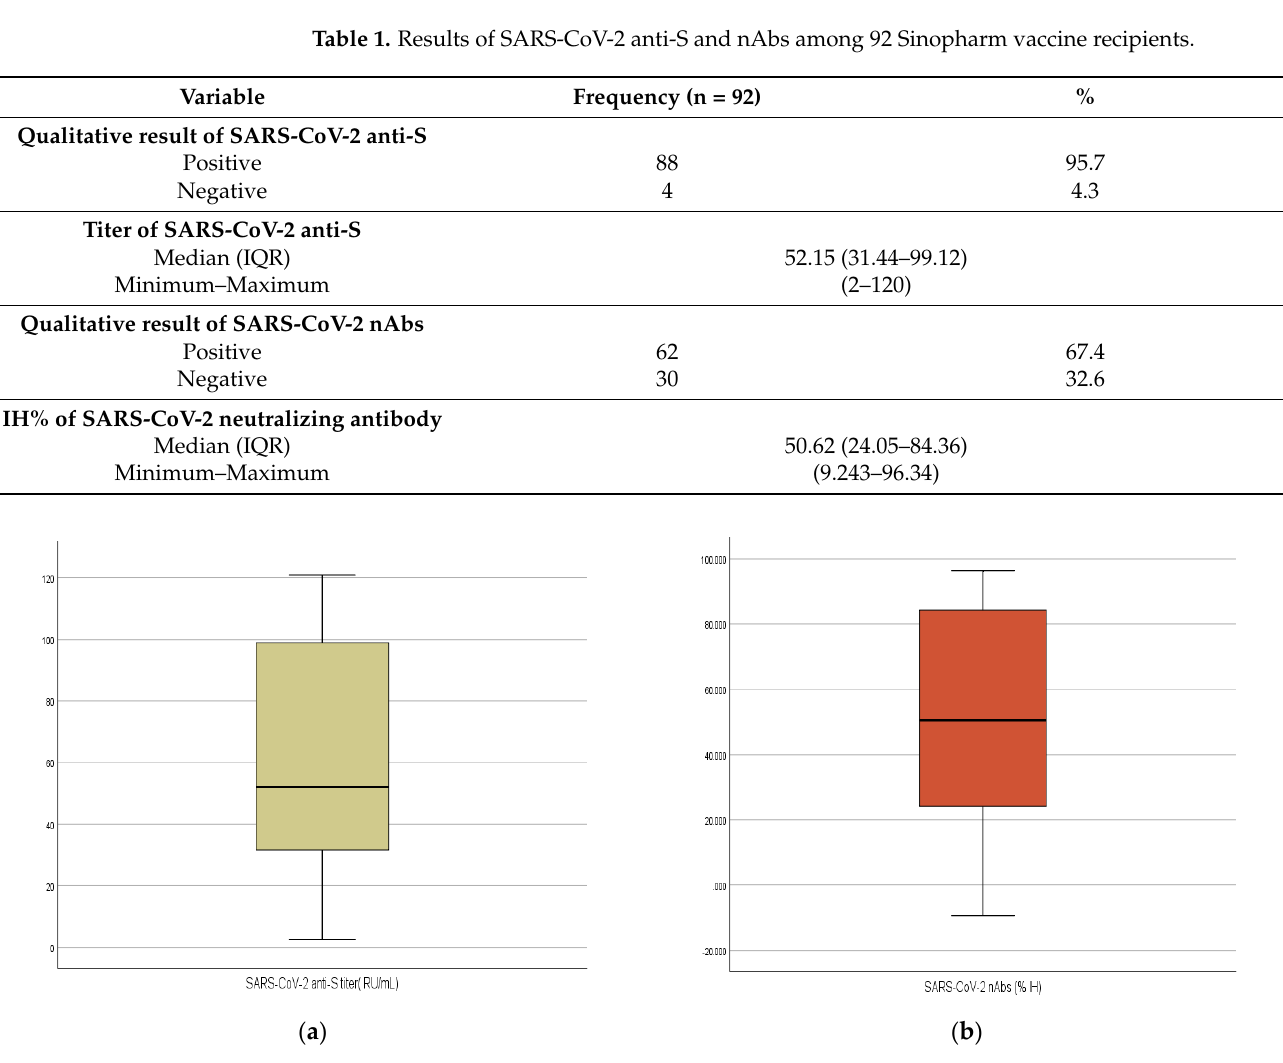
Figure 1. ( a , b ): Boxplot illustrating the differences in the titers of SARS-CoV-2 anti-S and %IH of nAbs of 92 Sinopharm vaccine recipients.